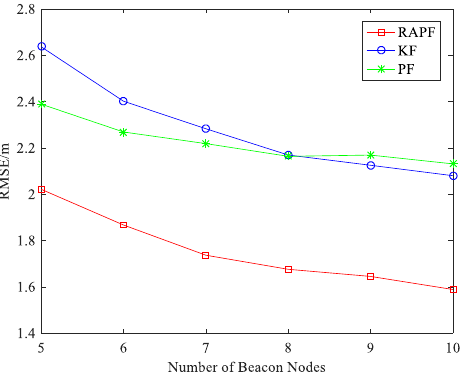
Figure 8. The RMSE versus the number of beacon nodes.